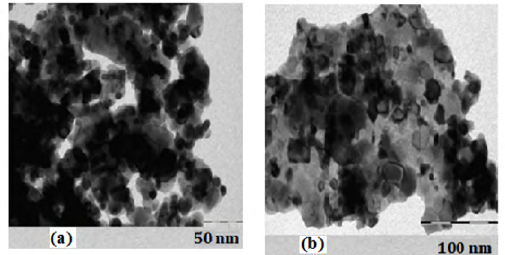
Ni AlCrO (where x = 1-x x 4